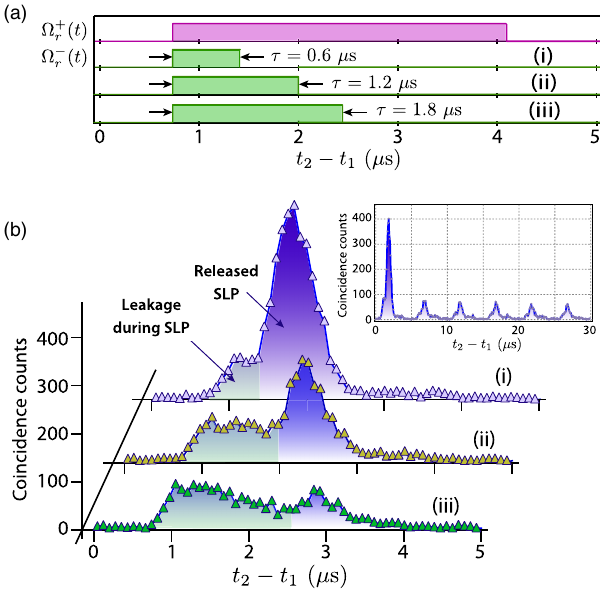
FIG. 3. Formation of the single-photon SLP. (a) The two and Ω − are simultaneously counter-propagating read lasers Ω þ r r turned on 0 . 8 μ s after the write pulse. After a specified trapping time τ , Ω − is turned off and released is the heralded single-photon r from the atomic cloud as the anti-Stokes photon. The trapping times are, (i) τ ¼ 0 . 6 μ s, (ii) τ ¼ 1 . 2 μ s, (iii) τ ¼ 1 . 8 μ s. (b) The TCSPC histogram shows the waveform of the released single- photon. During the formation of the single-photon SLP, emission of the anti-Stokes photon is greatly suppressed, albeit showing some leakage. When the read laser Ω − is turned off, the remaining r single-photon SLP is released. Each TCSPC histogram is accumulated for 3000 s. Inset shows the extended region for case (i), in which uncorrelated counts are also presented. Since the write/read pulses are applied at every 5 μ s, the coincidence count peaks appear at every 5 μ s in the TCSPC histogram. The pronounced peak at 2 μ s is due to the quantum-correlated photon pair generated by the corresponding write/read pulse sequence. The other low-lying periodic peaks represent uncorrelated ran- dom coincidence counts due to a Stokes photon by a write pulse and an anti-Stokes photon by subsequent read